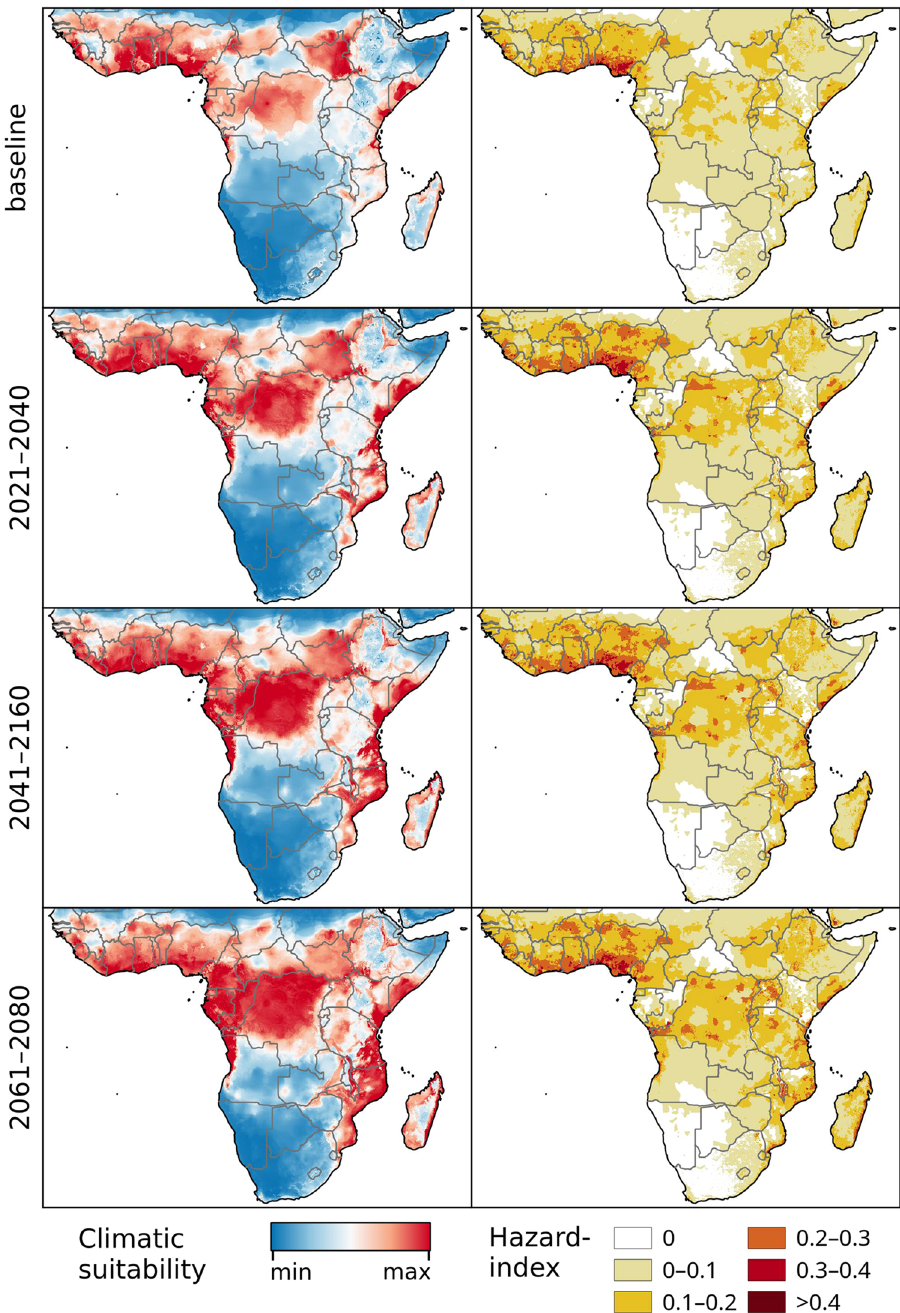
Figure 2. Chikungunya under the baseline and RCP 8.5 climate change scenarios in Africa. Left: Climatic suitability, right: hazard index. Climate change scenarios represent the mean model output obtained through the 5 GCMs. Climatic suitability output is scaled to the over-all global minimum (0) and maximum (0.623) values observed in any model. Maps were generated using the “raster” package in R 3.3.2 (https://www.r-project. org/) and QGIS 2.8.1